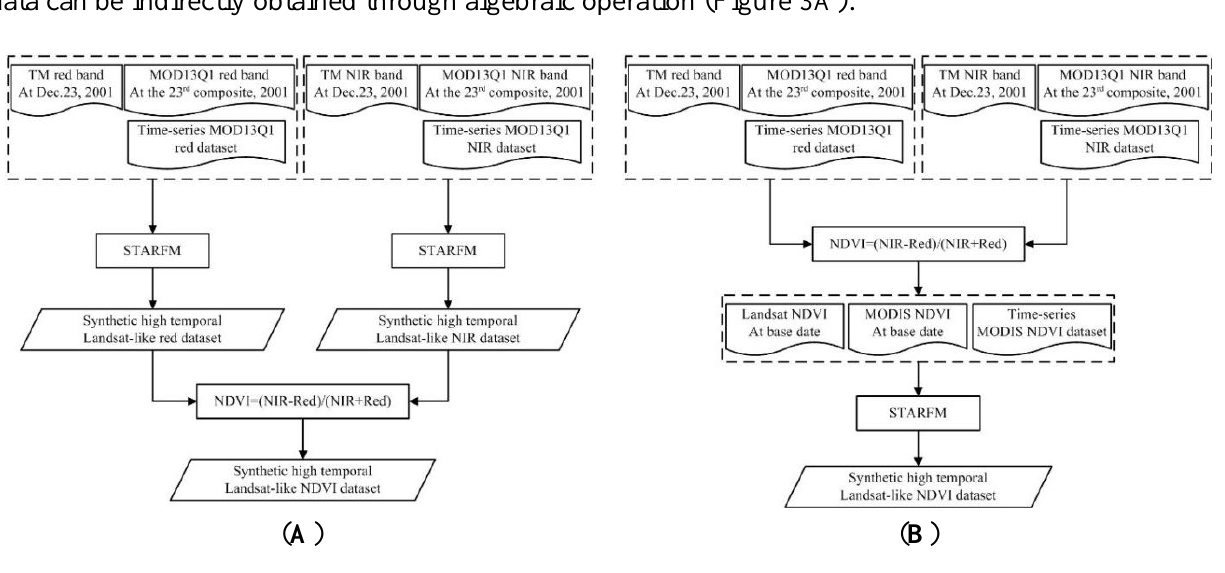
Figure 3. The flowchart of Scheme 1 ( A ) and Scheme 2 ( B ) for synthesizing the